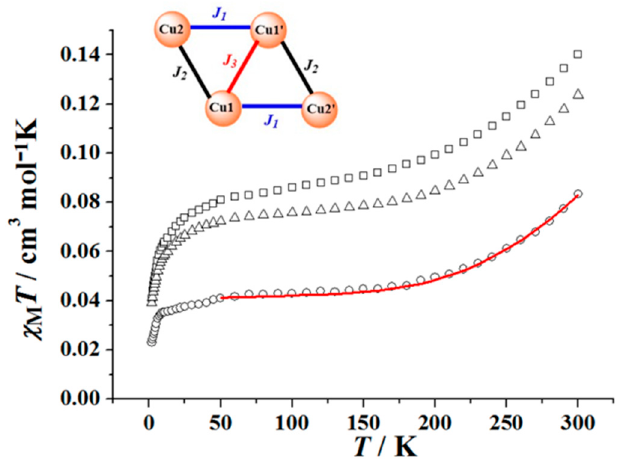
Figure 11. χ M T vs. T plot for 9 (circles) Fe@ 9 -1 (triangles) and Fe@ 9 -2 (squares). Solid line represents the best fit for 9 . Inset: the exchange interactions in 9 .